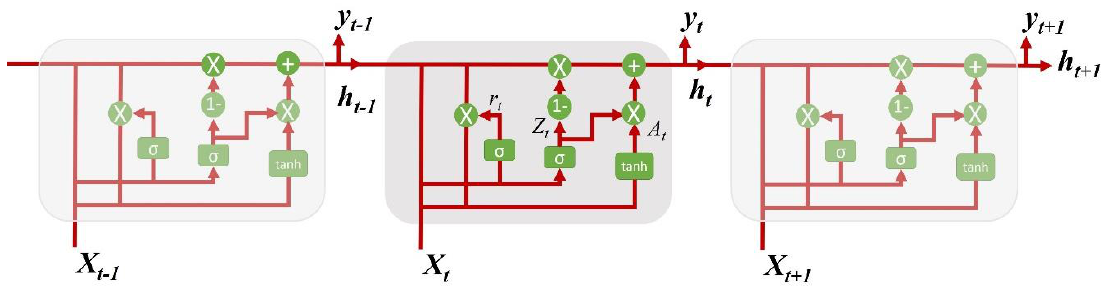
Figure 6. The structure of the gated recurrent unit network.